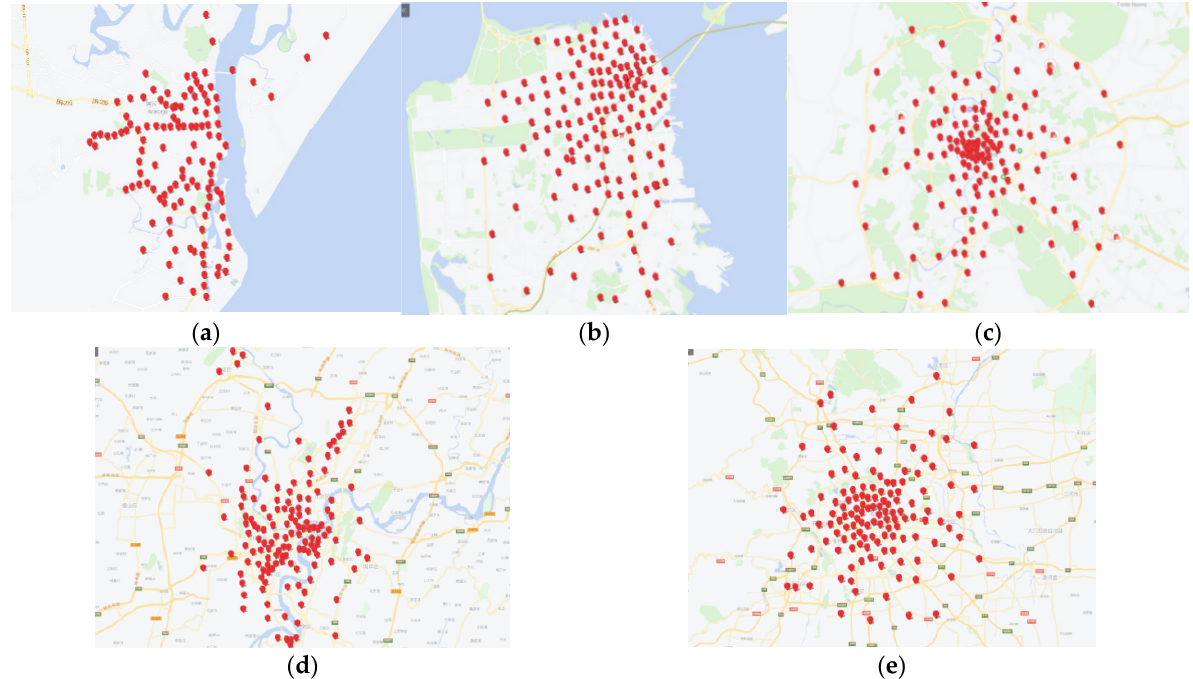
Figure 12. The city hotspot markers for the city taxi GPS data found by the noise-based K-means method: ( a ) Aracaju (Brazil), ( b ) San Francisco (USA), ( c ) Rome (Italy), ( d ) Chongqing (China), ( e ) Beijing (China). As can be seen from Figures 9–12, the spatial distributions of urban hotspots have been captured by the FCM, K-means and K-means plus clustering algorithms for the given